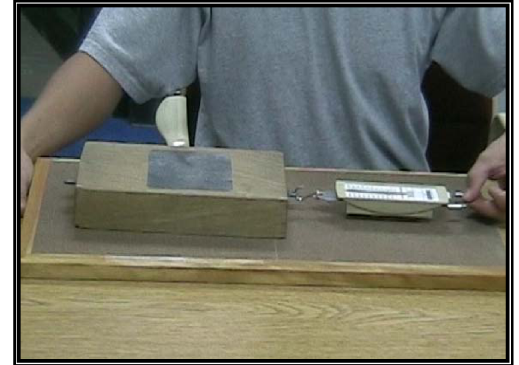
FIG. 4 (color online). Model-eliciting activity 2: A wooden block is dragged along a plank with half of it being covered by